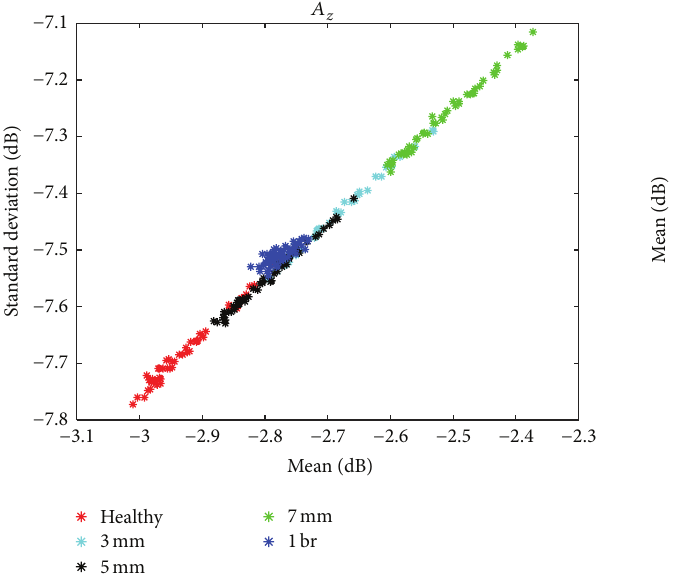
Figure 7: Unload condition analysis, 𝐴 𝑧 -axis.